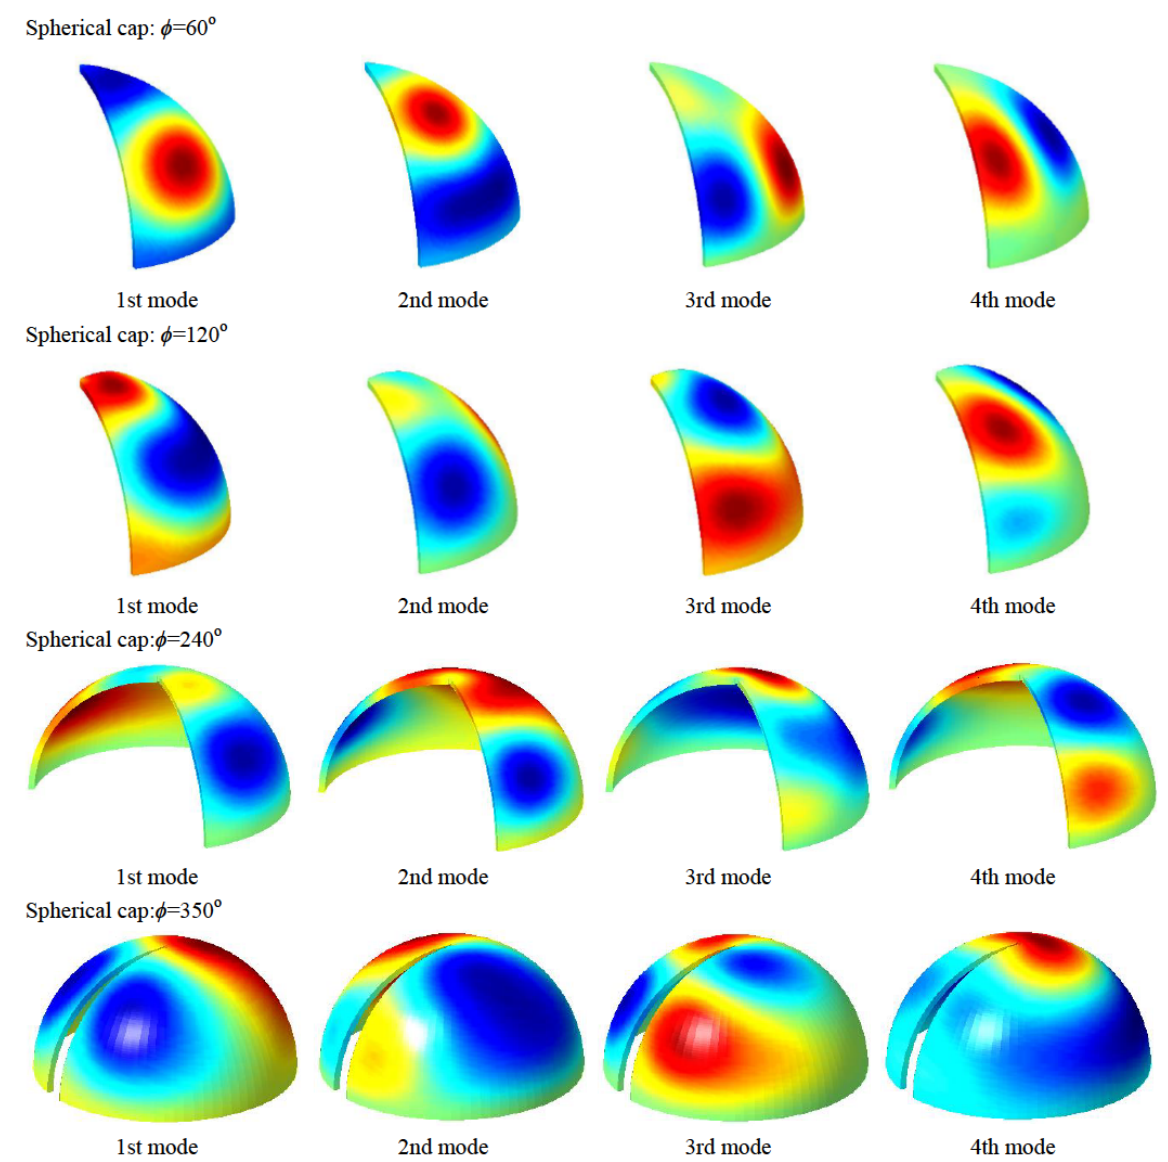
Figure 9: Mode shapes of the Spherical panel with E 1 CE 1 boundary condition.